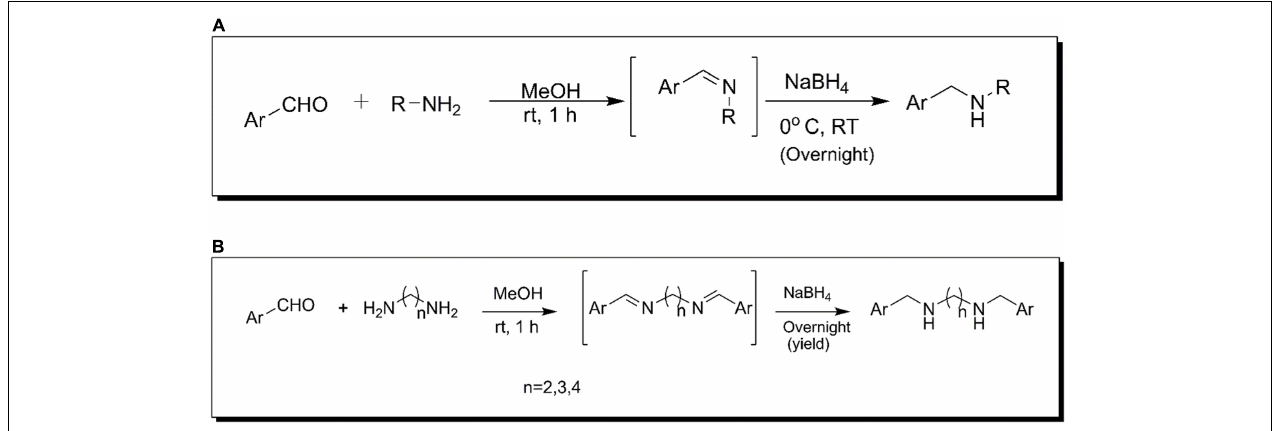
FIGURE 1 | Schematic representation of the reaction scheme for synthesis of (A) acyclic amines (B) acyclic diamines.